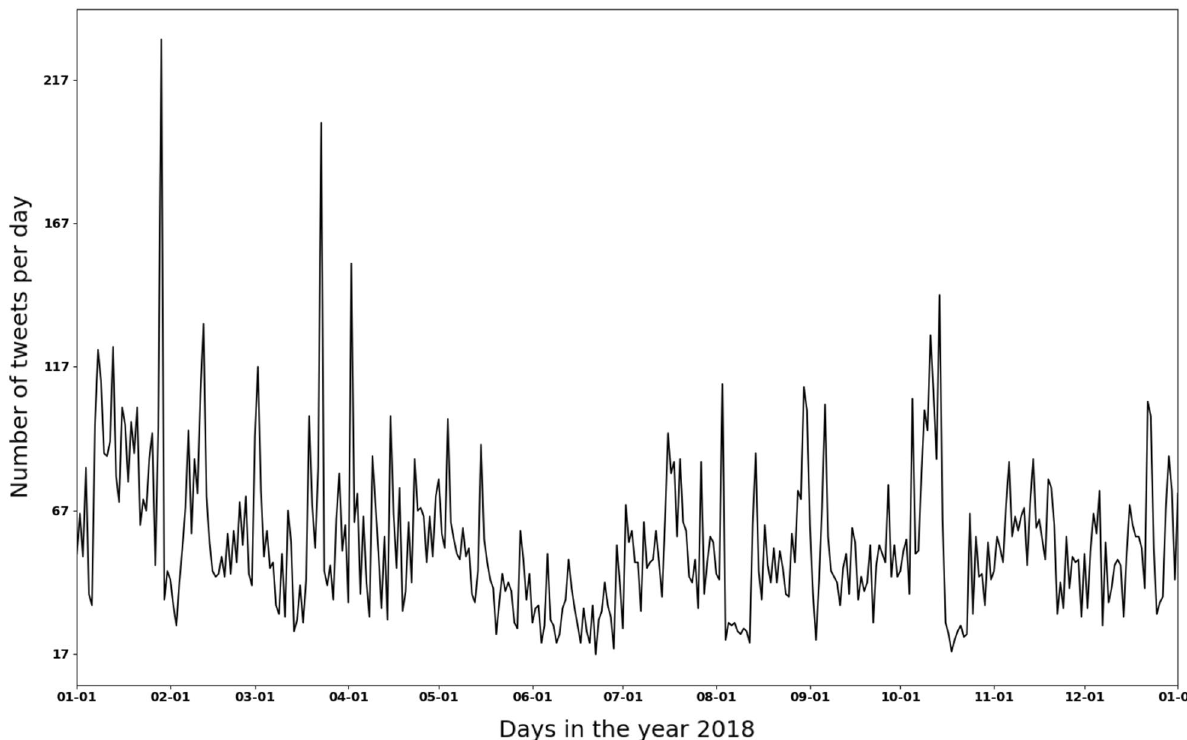
Figure 5. Number of tweets related to foodborne illness incidents in the United